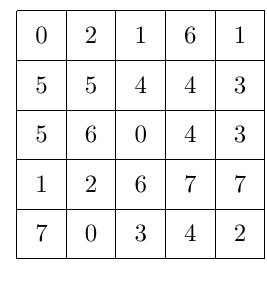
Figure 8: ρ -shift offsets, that is the positions in each lane where bits of slice z = 0 before the application of ρπ are relocated.